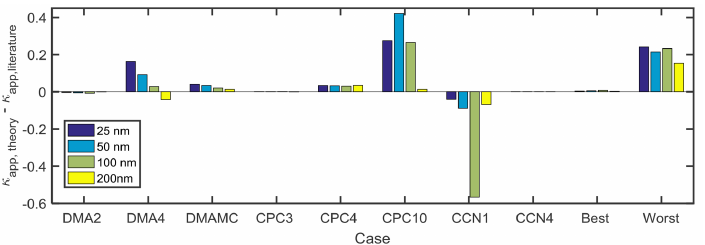
Figure 10. Comparison of κ app artifacts derived from best and worst case scenarios for instrumental measurements for sodium chloride. Combined artifacts for the lowest-artifact cases (best: DMA case 2, CPC case 3, and CCN case 4) and the highest-artifact cases (worst: DMA case 4, multiple charging, CPC case 4, CPC case 8, and CCN case